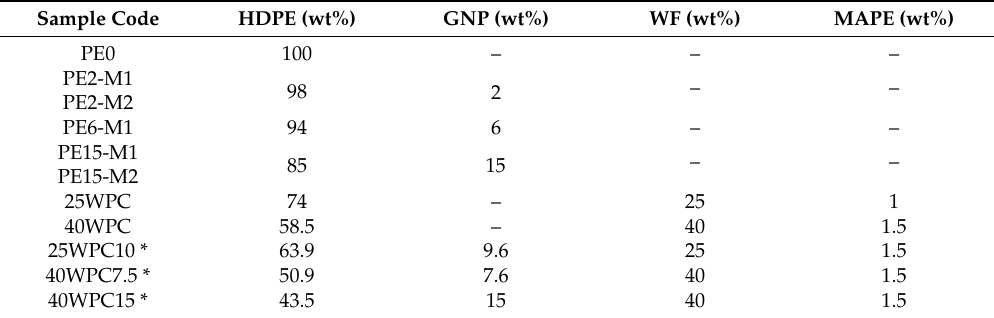
Table 2. Name and composition of the studied